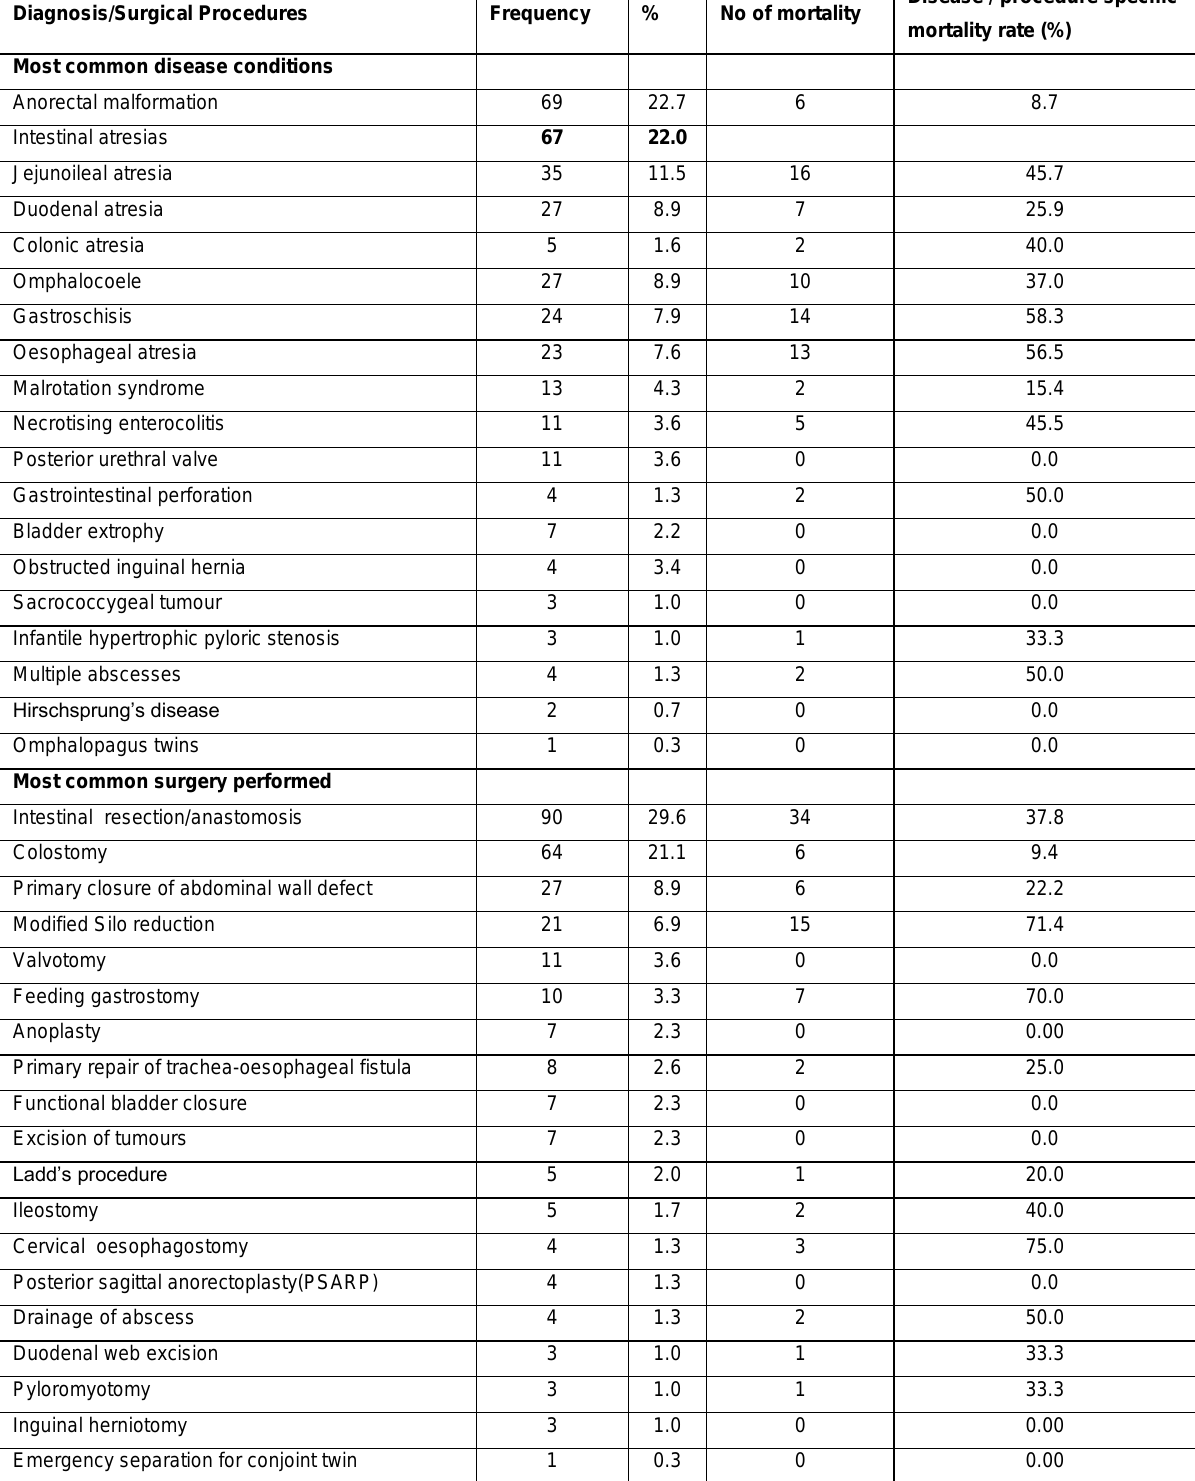
Table 2: showing the common conditions and surgical procedures done with case specific mortalities Diagnosis/Surgical Procedures Frequency % No of mortality